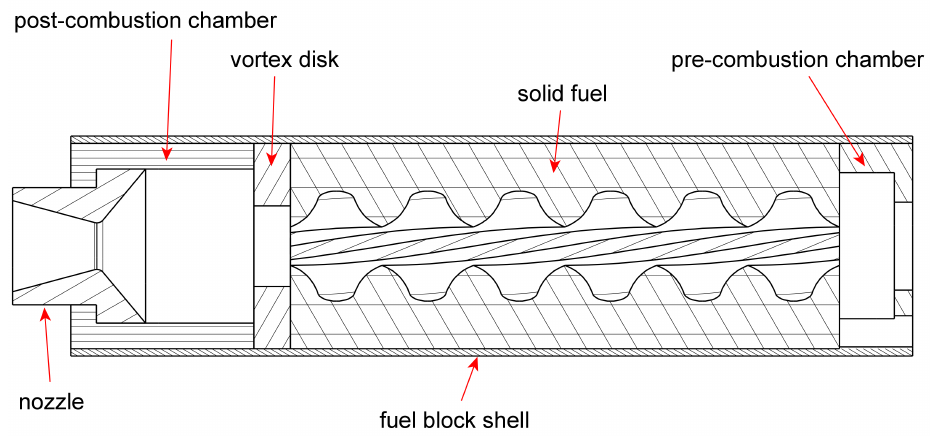
Figure 6. Sectional view of the solid fuel block.